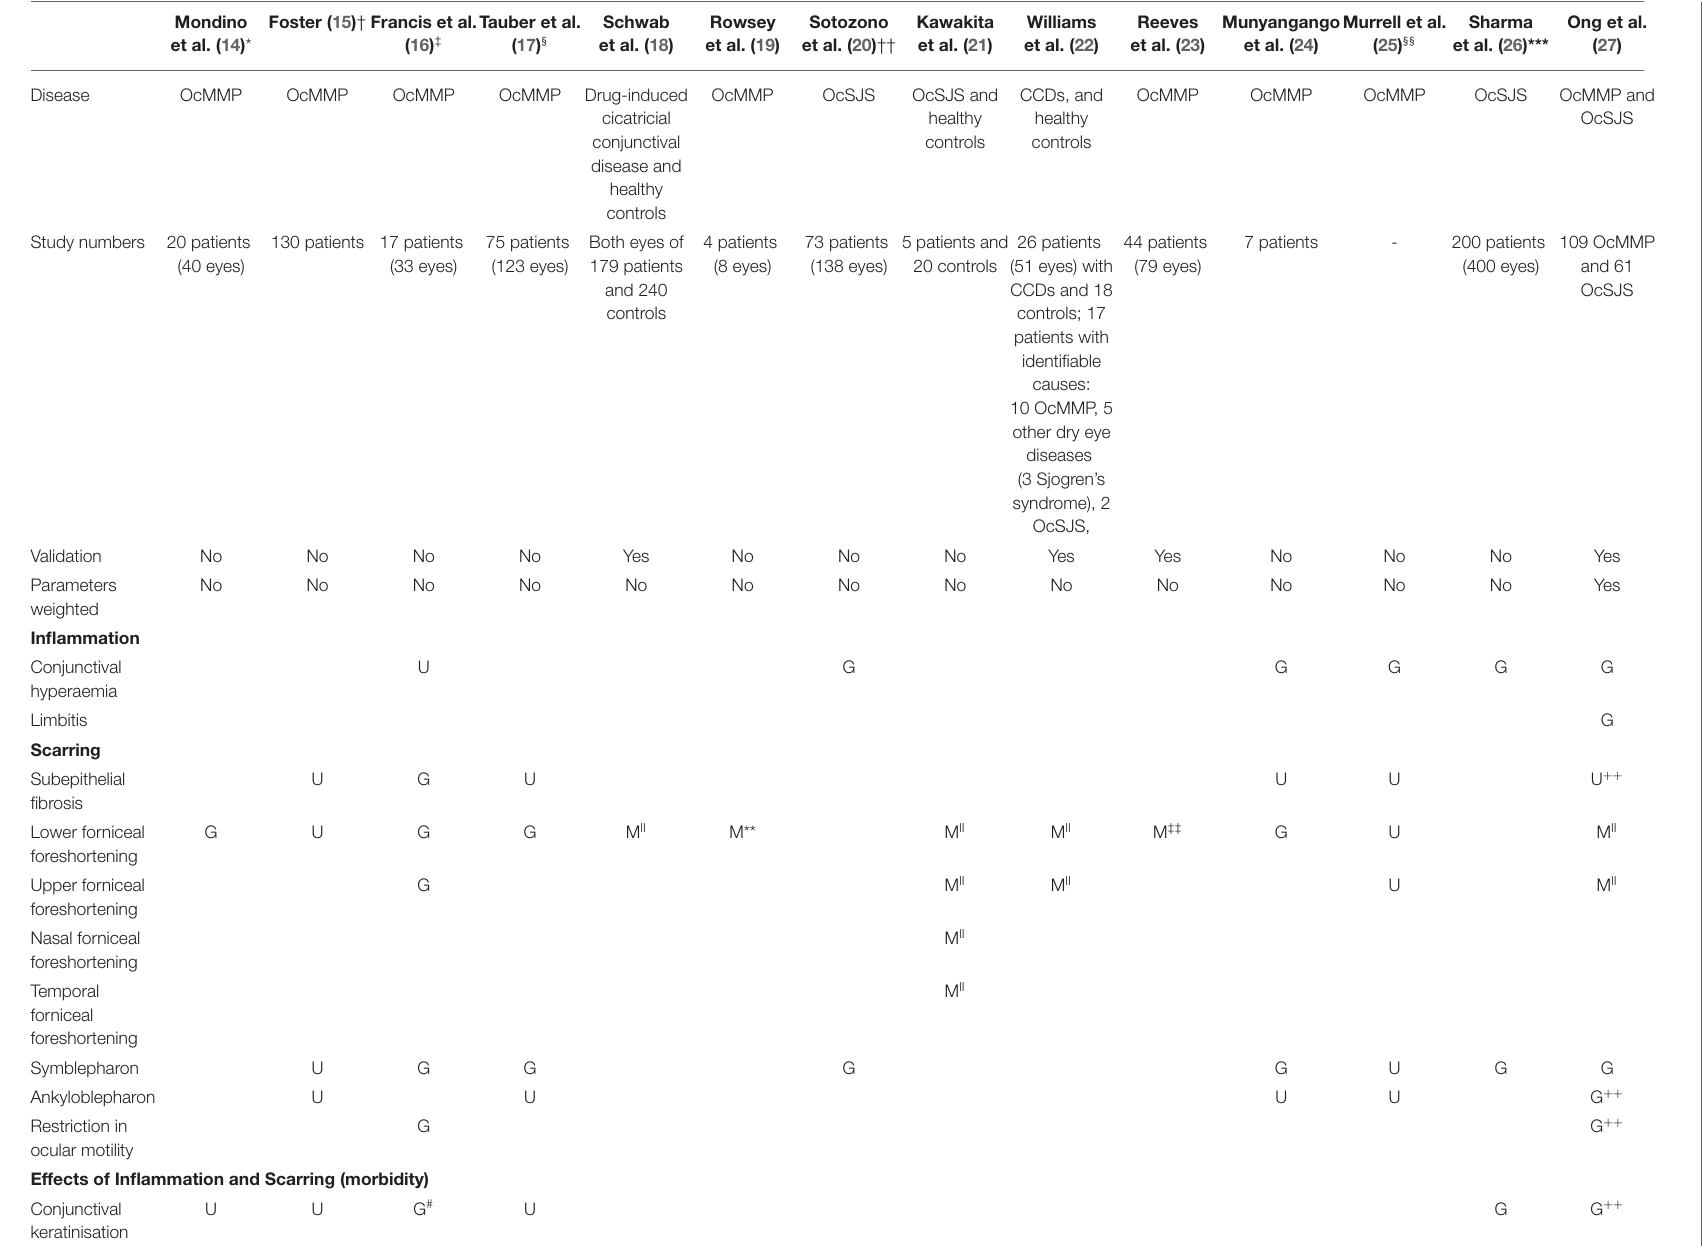
TABLE 1 | Summary of clinical disease scoring systems for cicatricial diseases of the